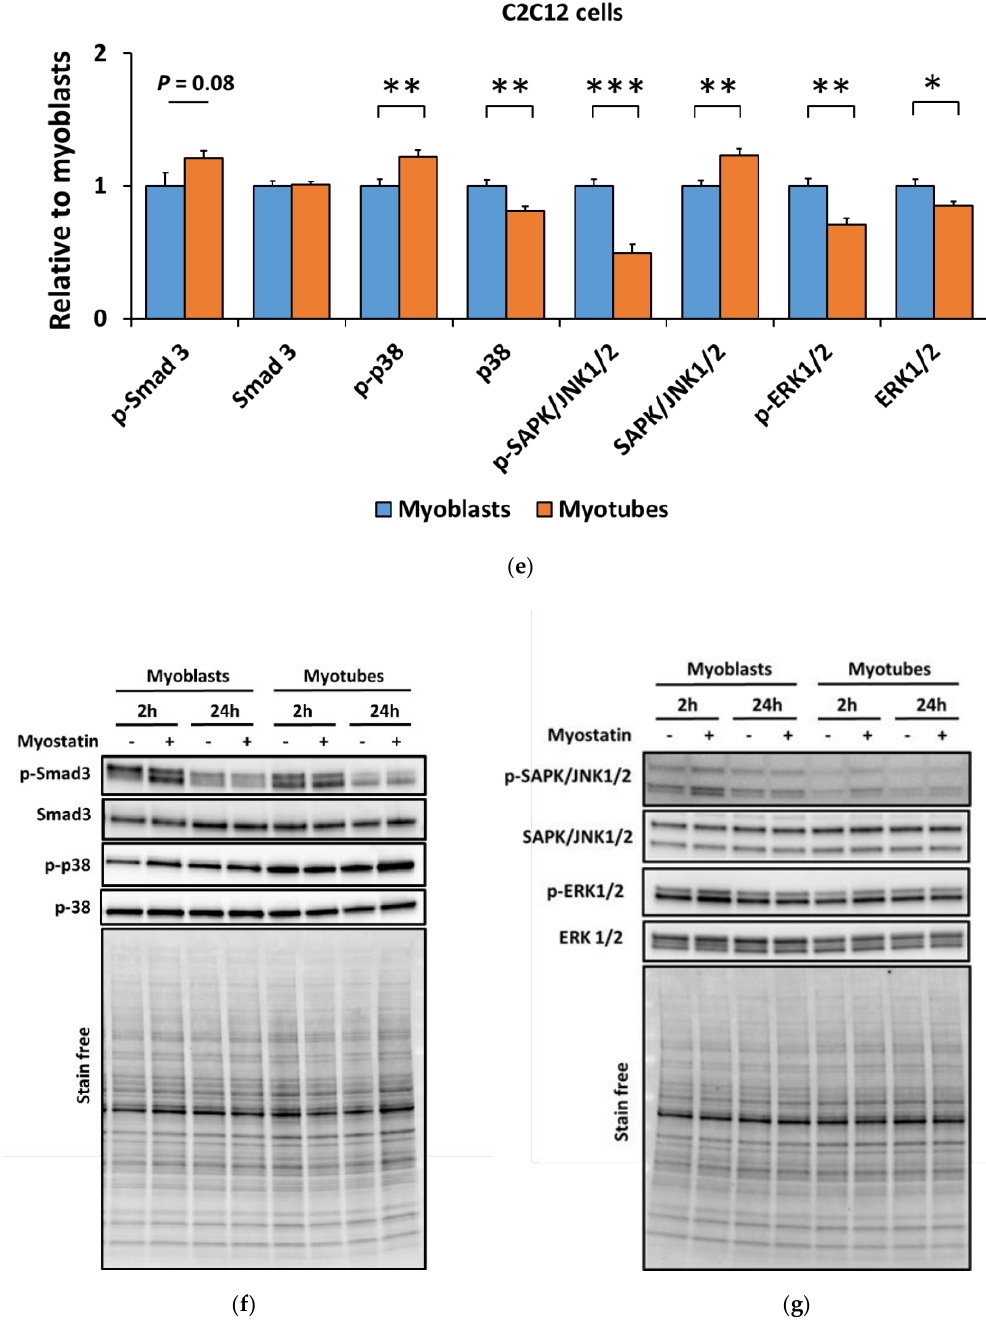
Figure 1. Myostatin-induced changes in the canonical (Smad3) and noncanonical (MAPKs) pathways were greater in C2C12 myoblasts than they were in myotubes. ( a ) Phosphorylated Smad3 Ser423/425 and total Smad3 in myoblasts and myotubes. ( b ) Phosphorylated p38 Thr180/Tyr182 and total p38 in myoblasts and myotubes. ( c ) Phosphorylated SAPK/JNK1/2 Thr183/Tyr185 and total SAPK/JNK1/2 in myoblast and myotubes. ( d ) Phosphorylated ERK1/2 Thr202/Tyr204 and total ERK1/2 in myoblasts and myotubes. In the figures, the values are presented as normalized to CTRL = 1. ( e ) Nontreated CTRL myoblasts and myotubes of the 2-h and 24-h time-points were pooled and the values are presented as normalized to myoblasts = 1. ( f,g ) Representative blots. In A – D, N = 6 per group. In E, N = 12 per group. *, **, and *** = P < 0.05, P < 0.01, and P < 0.001, respectively. CTRL (-) = control group, MSTN (+) = myostatin group. The 2 h myostatin administration promoted typical inflammatory pathways in the C2C12 cells, shown by the elevated phosphorylation of STAT3 Tyr705 in both myoblasts and myotubes ( P < 0.001 and P < 0.01, respectively, Figure 2a,d) a nd phosphorylated C/EBPβ Thr235 in the myoblasts ( P < 0.01, Figure